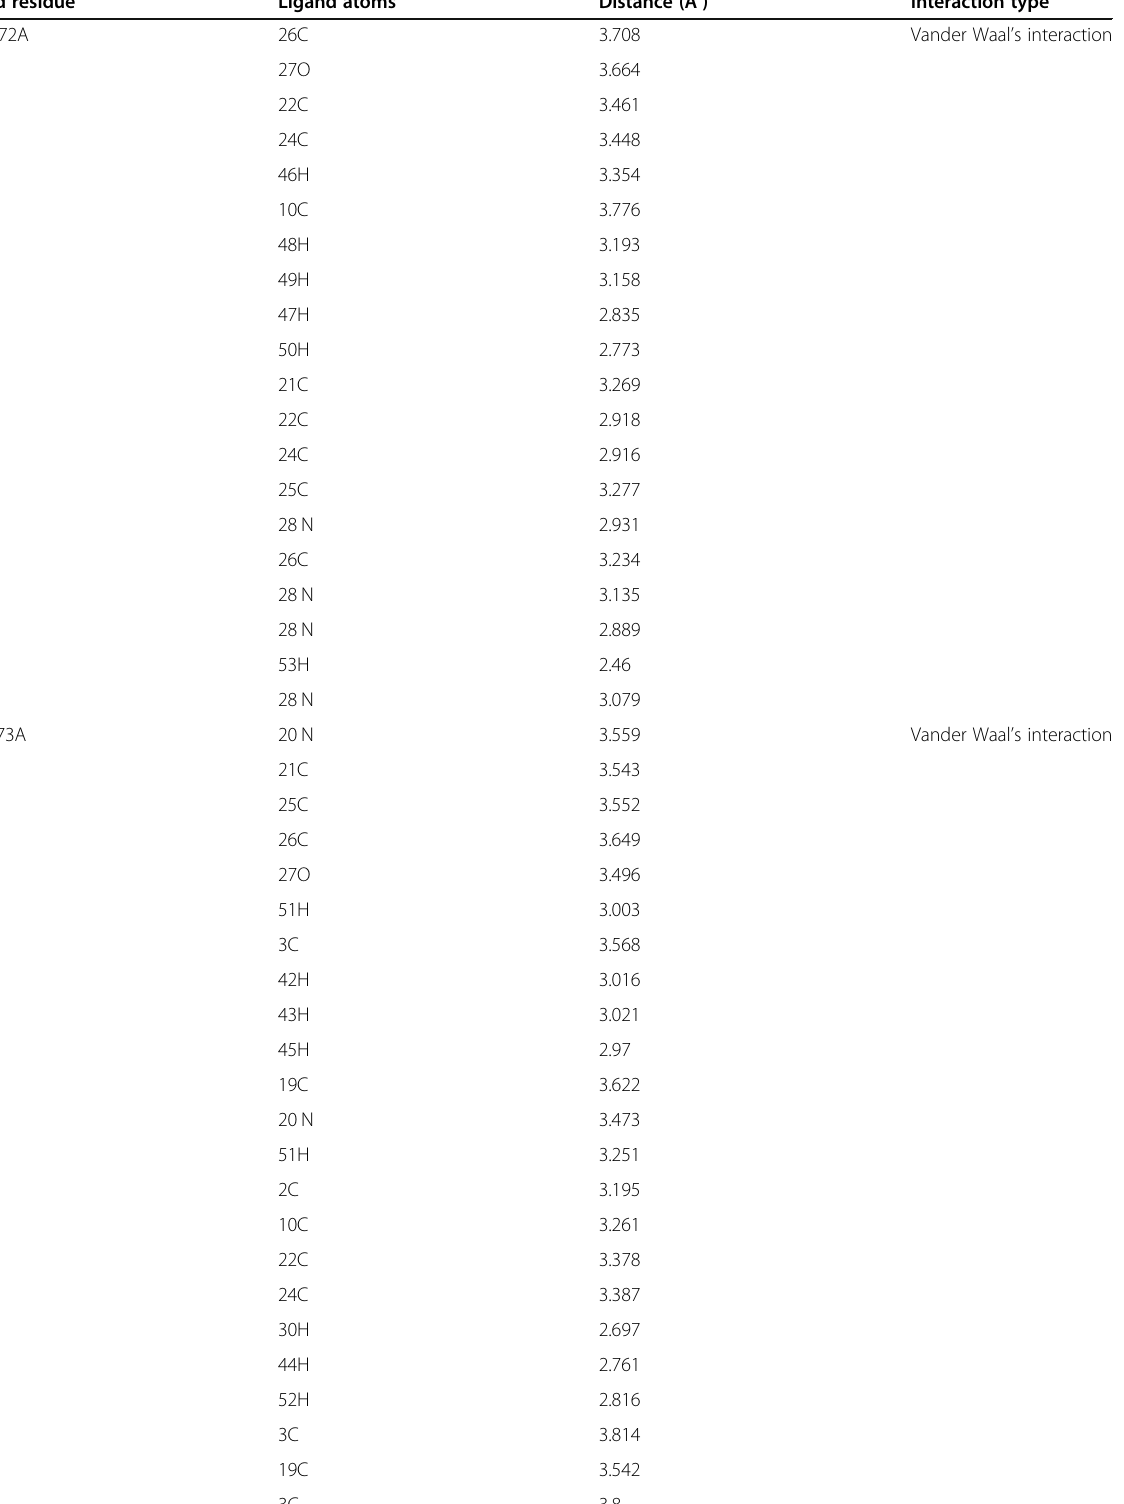
Table 5 Docking interaction of compound 51 with the binding pocket of